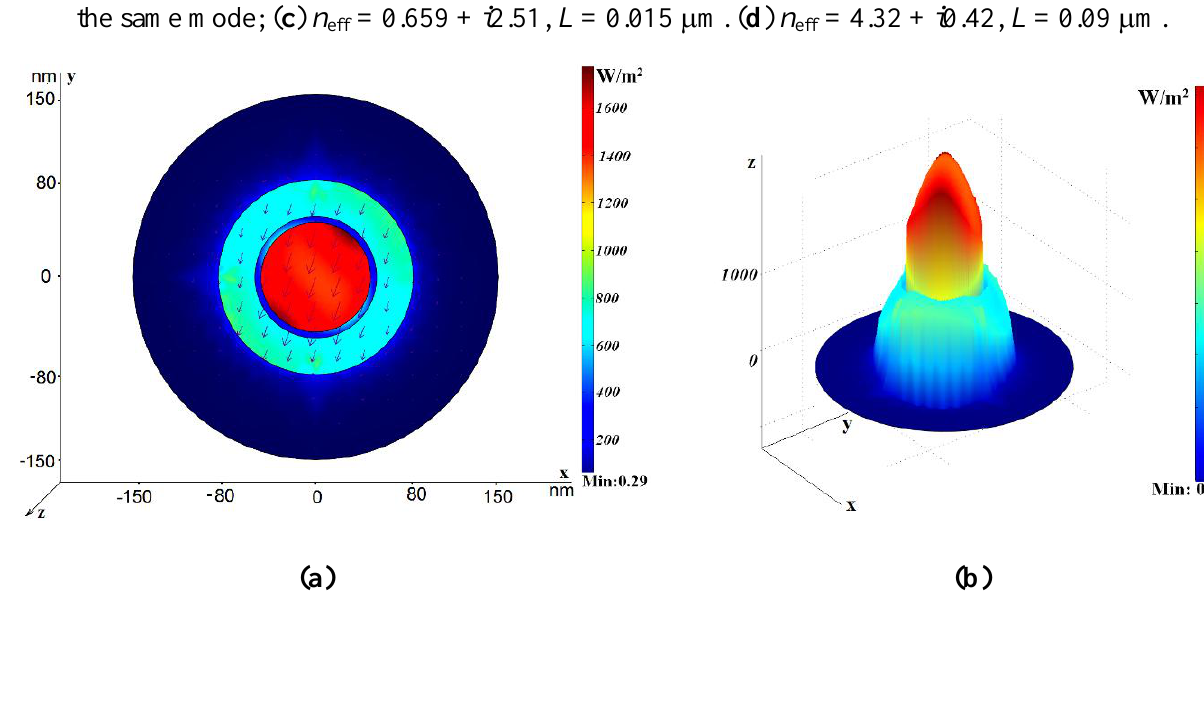
Figure 2. Power flow distribution for the various modes in the case r h = 70 nm, R = 150 nm. The electric field vector is shown by arrows. ( a ) The dipole-like 2 out mode, n = 0.742 + i 0.026, L = 1.5  m; ( b ) Three-dimensional power flow distribution for eff the same mode; ( c ) n = 0.659 + i 2.51, L = 0.015  m. ( d ) n eff